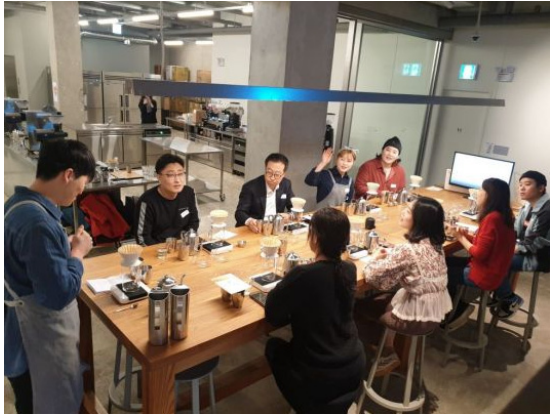
Figure 31. Blue Bottle Coffee Class with Seongdong-gu: regional co-prosperity between Blue Bottle and Seongdong-gu [82].